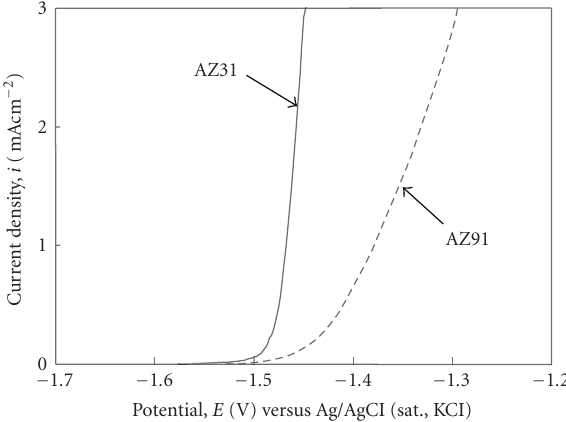
Figure 5: Anodic polarization curves of AZ31 and AZ91 magne- sium alloys in 17 mMNaCl and 0.1 MNa 2 SO 4 solution.